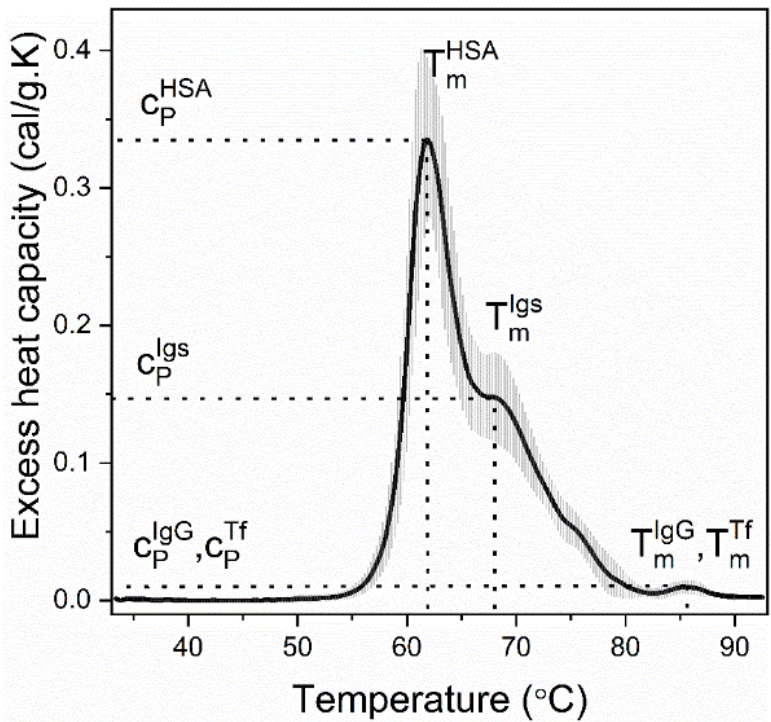
Figure 1. Control set of serum thermograms (mean, black line; SD, grey shadow) derived for healthy individuals. Before analysis, buffer – buffer scans, routinely measured before each experiment, were subtracted from the serum scans; the resulting traces were then corrected either by linear baseline or by interpolating sigmoidal baseline (when the slopes of the pre- and post-transition baseline differed) and normalized to the total protein concentration. The transition temperatures of the successive thermal transitions assigned to the major serum proteins: albumin (T mHSA and c PHSA ) and immunoglobulins (T mIgs and c PIgs ) and the high temperature transition to transferrin (T mTf and c PTf ) and IgG (T mIgG and c PIgG ) are indicated.